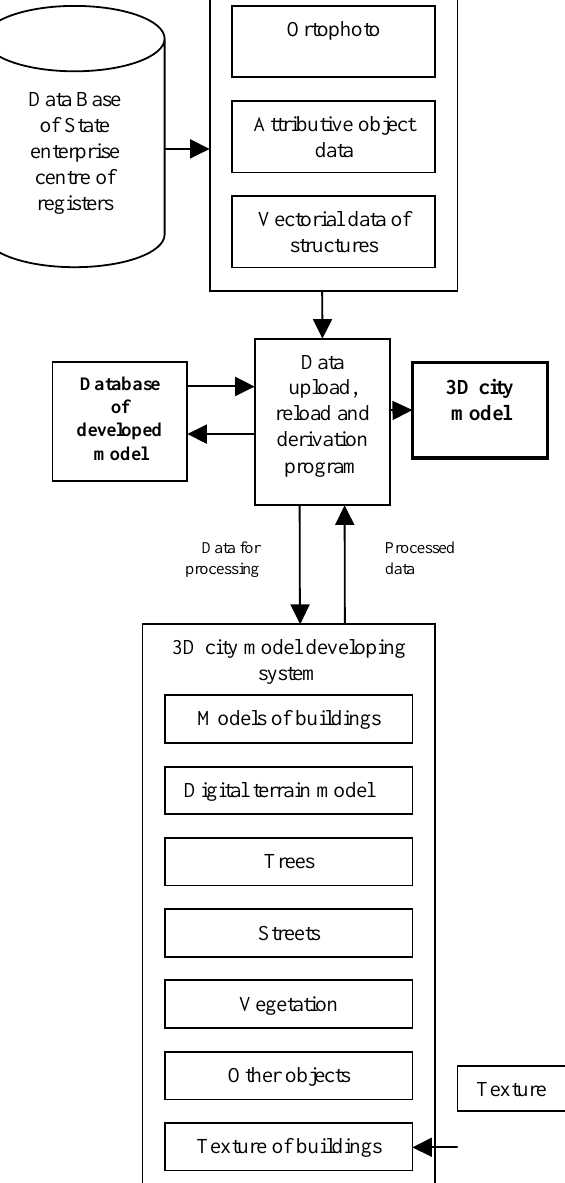
Fig 3 . A scheme of application of cadastral data in 3D city model